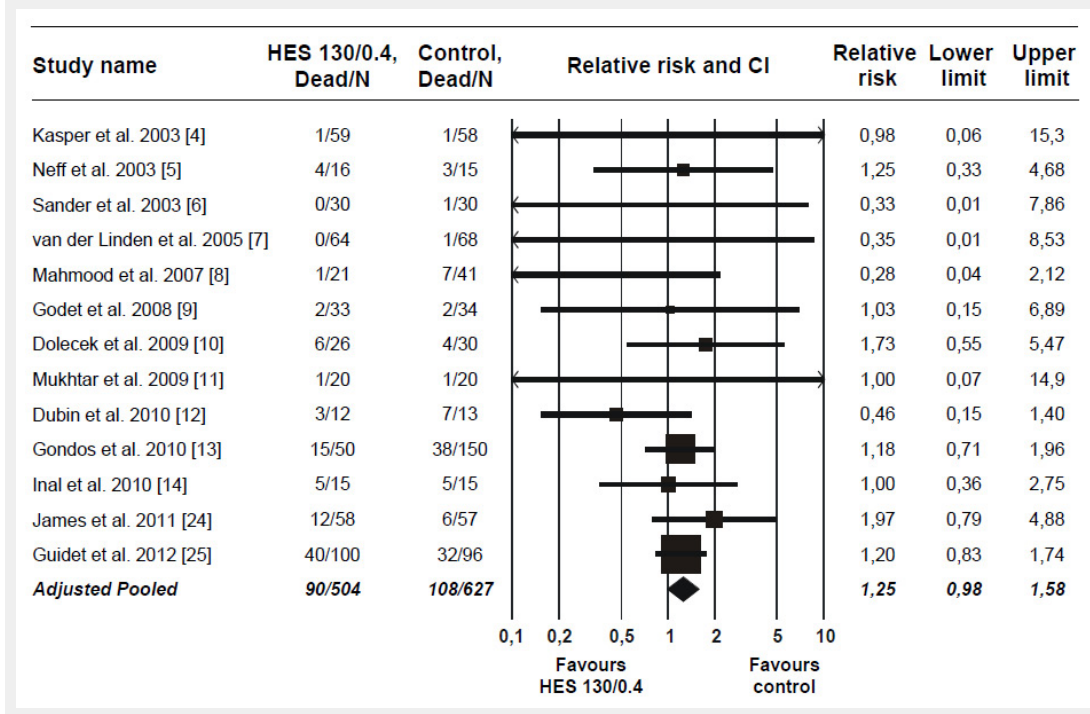
Figure 2 Relative risk of mortality after HES 130/0.4 infusion in RCTs. Pooled relative risk adjusted for publication bias. For trials with more than one control group, data for the different control groups were pooled [8, 13]. In one trial with mortality reported separately for the first 24 hours and thereafter, the data for the two time periods were pooled [12]. Error bars indicate CI. Data points scaled according to meta-analytic weight. Abbreviations: CI, 95% confidence interval; HES, hydroxyethyl starch; RCT, randomised controlled